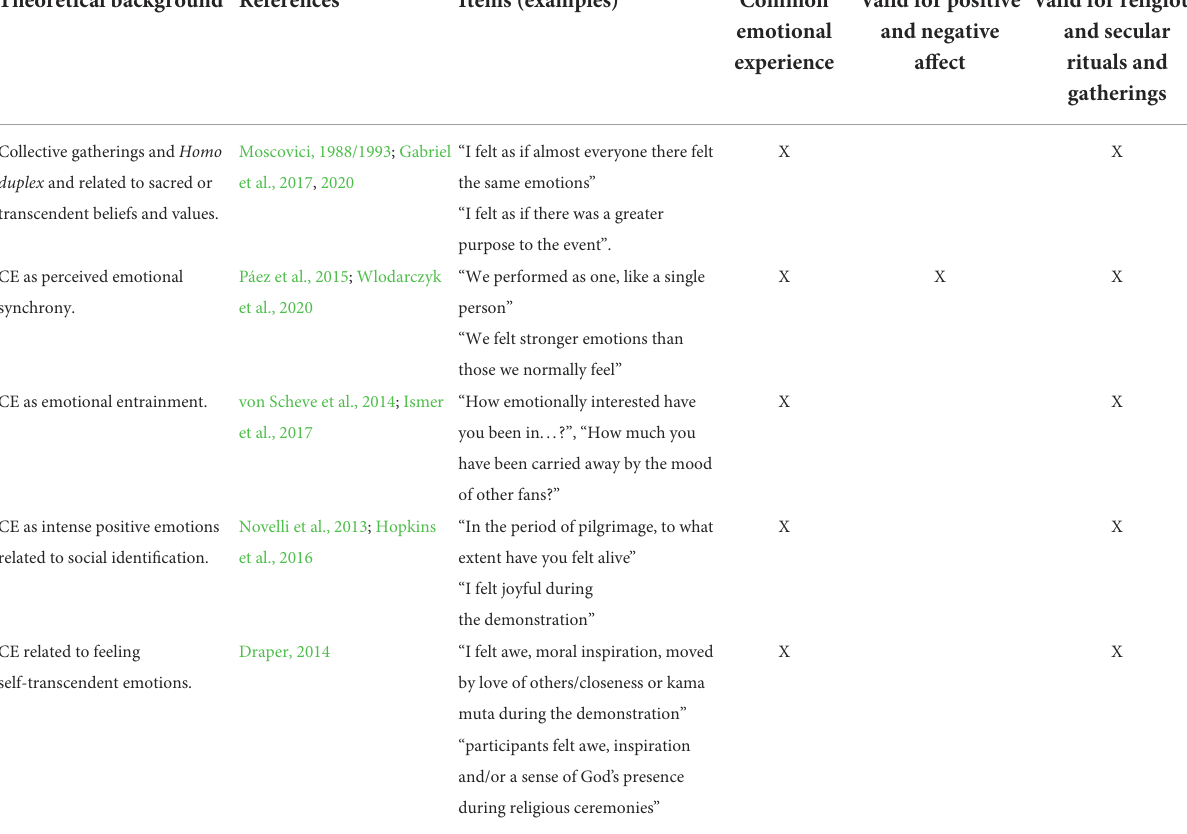
TABLE 1 Summary of approaches of empirical research on collective